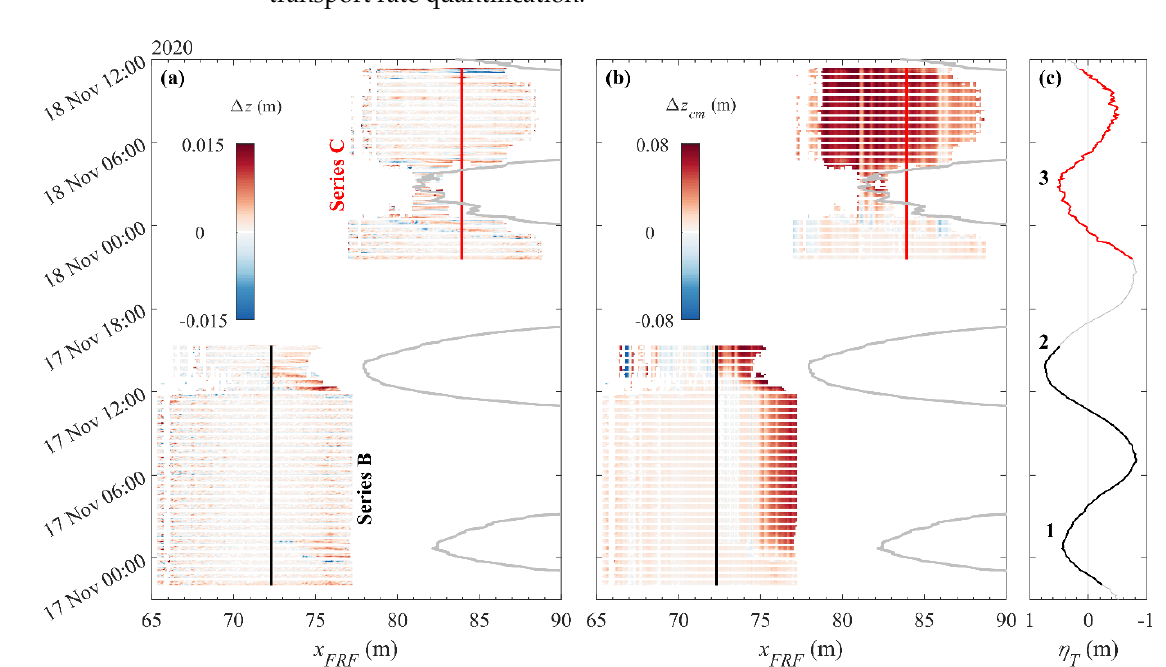
Figure 9. Beach profile elevation changes ( a ) progressively between successive profiles, ∆ z , and ( b ) cumulatively from the start of the series, ∆ z cm ; ( c ) measured tide elevation (NAVD88) – note the reversed horizontal axis. The thick black (red) lines running parallel to the time axes indicate the location of the LLC LiDAR puck for Series B (Series C). The thick grey line in ( a ) and ( b ) indicates where the measured tide elevation intersected the time-averaged FRF DUNE LiDAR beach profile. High tides in ( c ) are labeled 1, 2, and 3. Times in UTC.